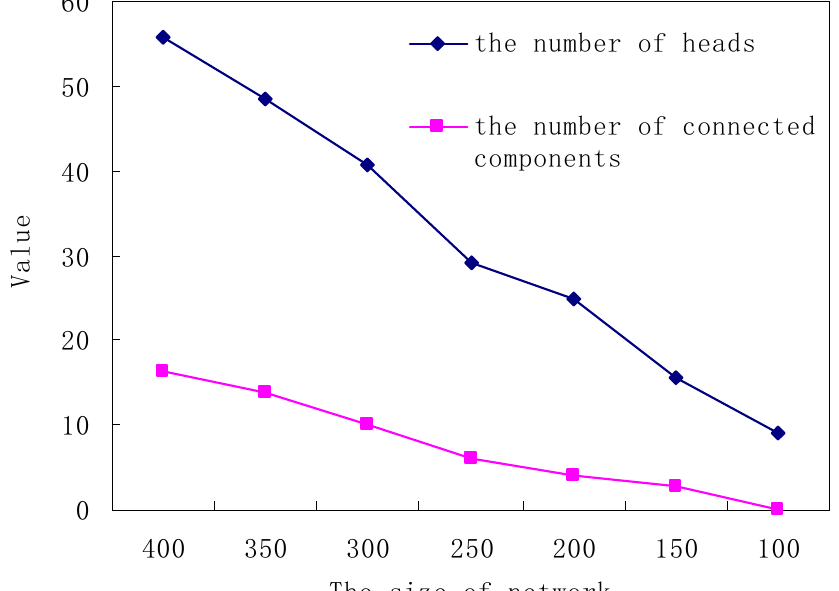
Figure 7. The number of heads and the number of connected